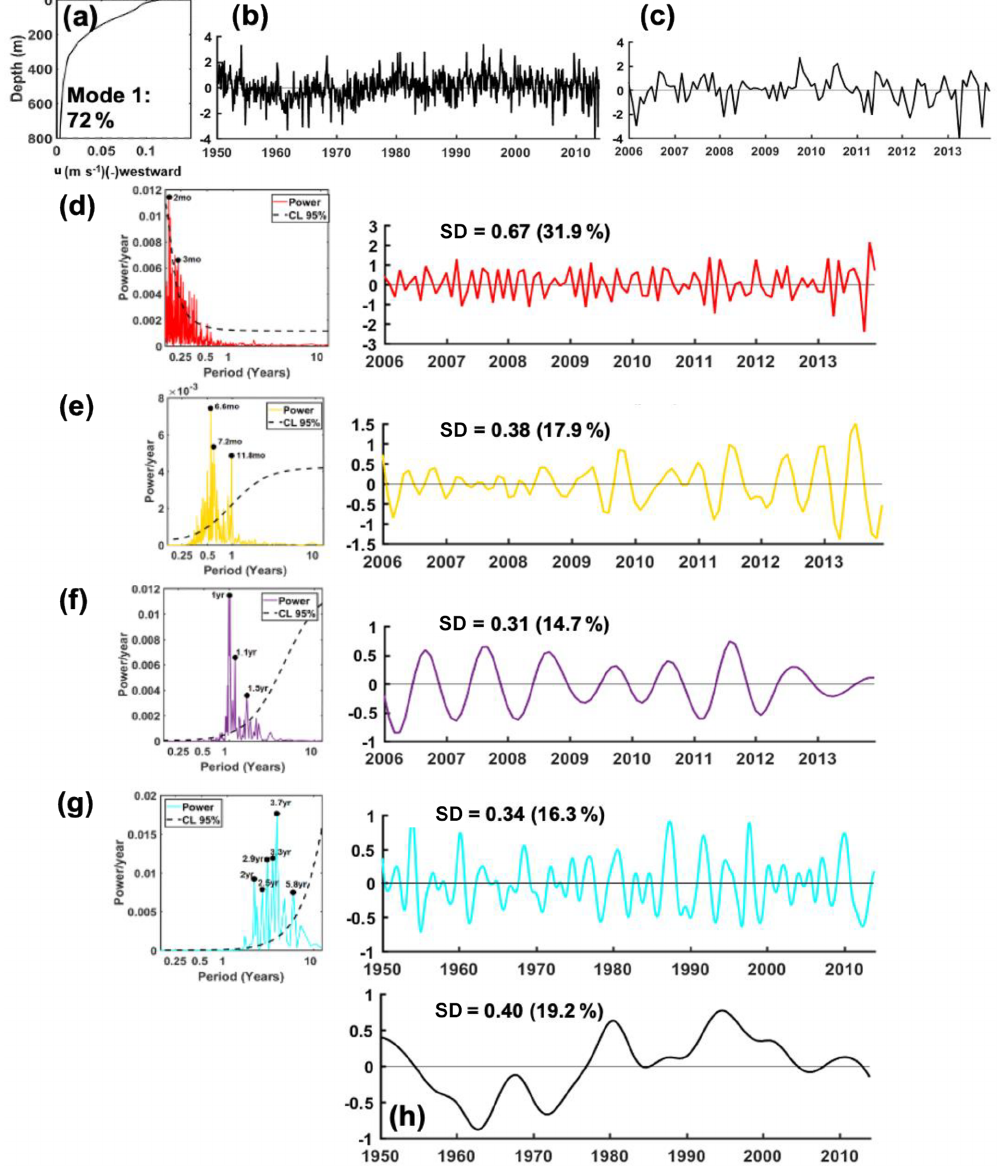
Figure 12. The same as Fig. 10 but for point C EJ , with the temporal variability of EOF1 accounting for 72% of total